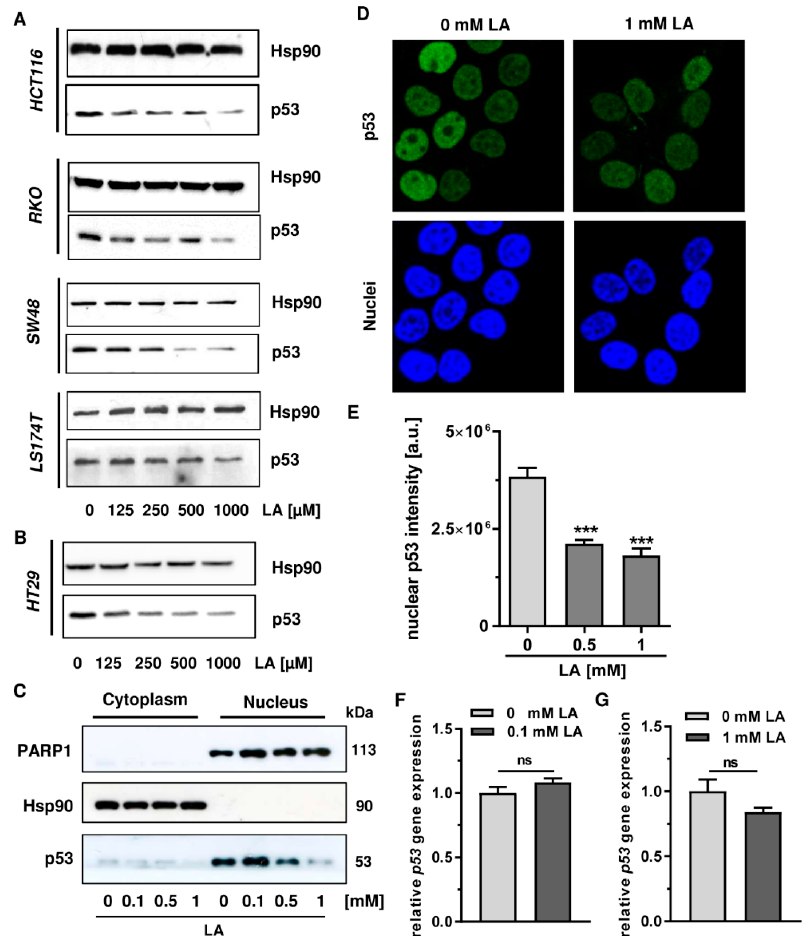
Figure 1. LA triggers depletion of p53 in CRC cells. ( A ) A panel of p53-wild type cells including HCT116, RKO, SW48, and LS174T were treated with increasing doses of LA for 48 h as indicated. EtOH was included as solvent control (0 µ M). Depletion of p53 was monitored using western blot analysis. Hsp90 was visualized as loading control. ( B ) The p53-mutated cell line HT29 was exposed to LA and p53 protein expression was analyzed as described in A. ( C ) HCT116 cells treated with increasing doses of LA were collected after 48 h and subjected to cell fractionation. Cytoplasmic and nuclear fractions were separated by SDS-PAGE followed by immunoblot analysis for p53 levels. Hsp90 served as loading control for the cytoplasm, while PARP1 was used as loading control for the nucleus. ( D ) Confocal microscopy of p53 was performed in HCT116 cells upon 48 h of incubation with 0 mM LA (EtOH as solvent control) or 1 mM LA. Fixed cells were stained with a p53-antibody followed by an Alexa488-coupled secondary antibody (displayed in green) and nuclei were counterstained using TO-PRO3 (blue). Representative images are shown. ( E ) Quantification of nuclear p53 intensity as assessed in D. Data is expressed as mean + SEM ( n = 3, at least 6 sections per group). *** p < 0.001. ( F , G ) Gene expression of p53 in LA-treated HCT116 cells using qPCR after 24 h incubation. EtOH was included as solvent control (0 mM). p53 expression levels are normalized to ACTB and GAPDH . Data is presented as mean + SEM ( n = 3). Ns, not significant. To further address this issue, p53 levels were assessed by western blot analysis already after 24 in a dose-dependent manner (Figure 2A,B). Furthermore, expression of p53-related genes was determined by quantitative real time PCR in HCT1116 cells. The positive control 5-FU, an